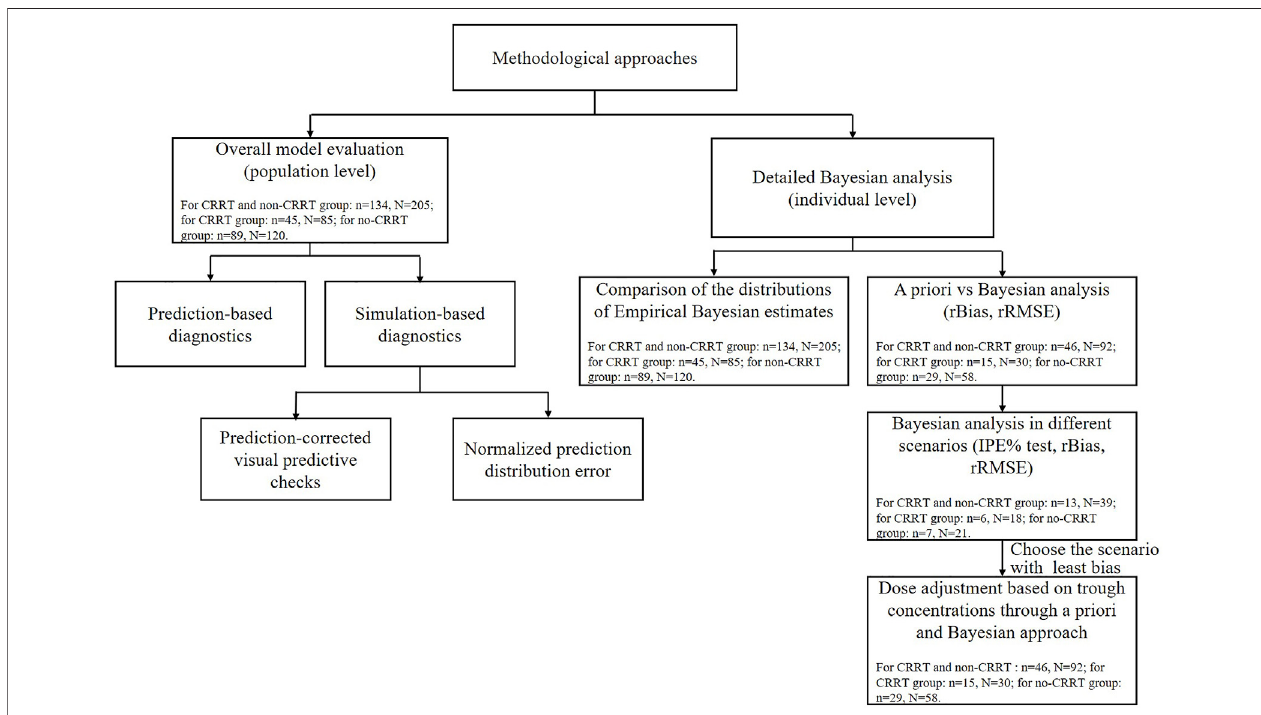
FIGURE 1 | The methodological steps and data used for the external evaluation study. N and n represent the meropenem samples and critically ill patients used in each step. IPE, rBias, and rRMSE represent the individual prediction error, relative bias, and relative root mean squared error, respectively.